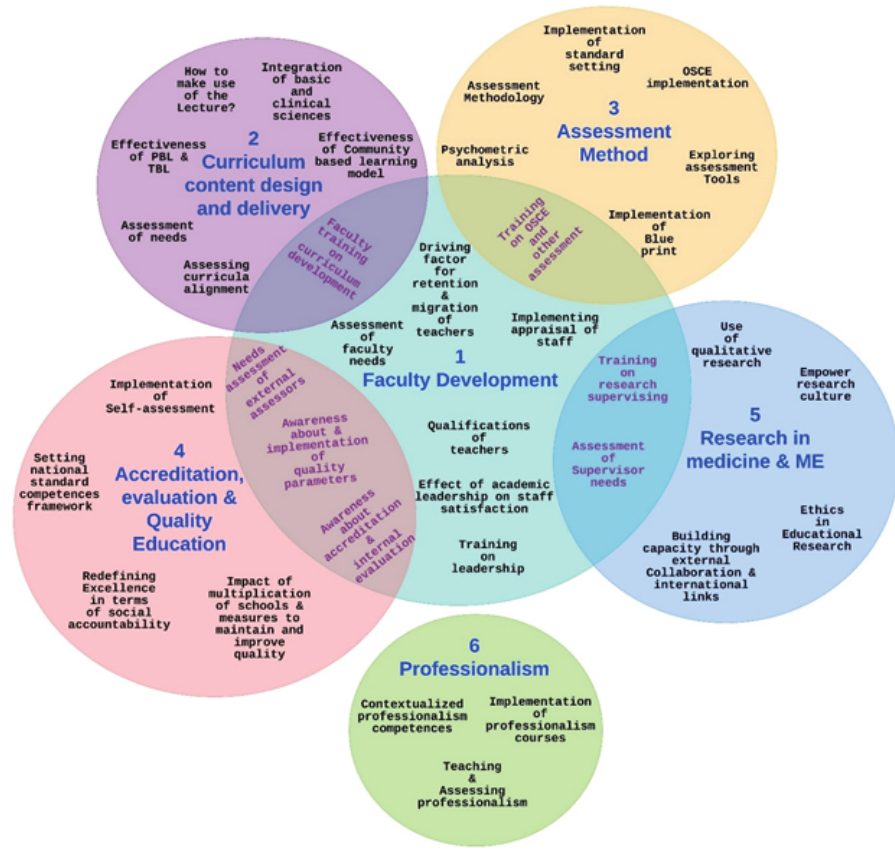
Figure 3 : MER priorities from the experts’ point of view: 6 principal themes, 36 subthemes. Faculty development appears central to the research